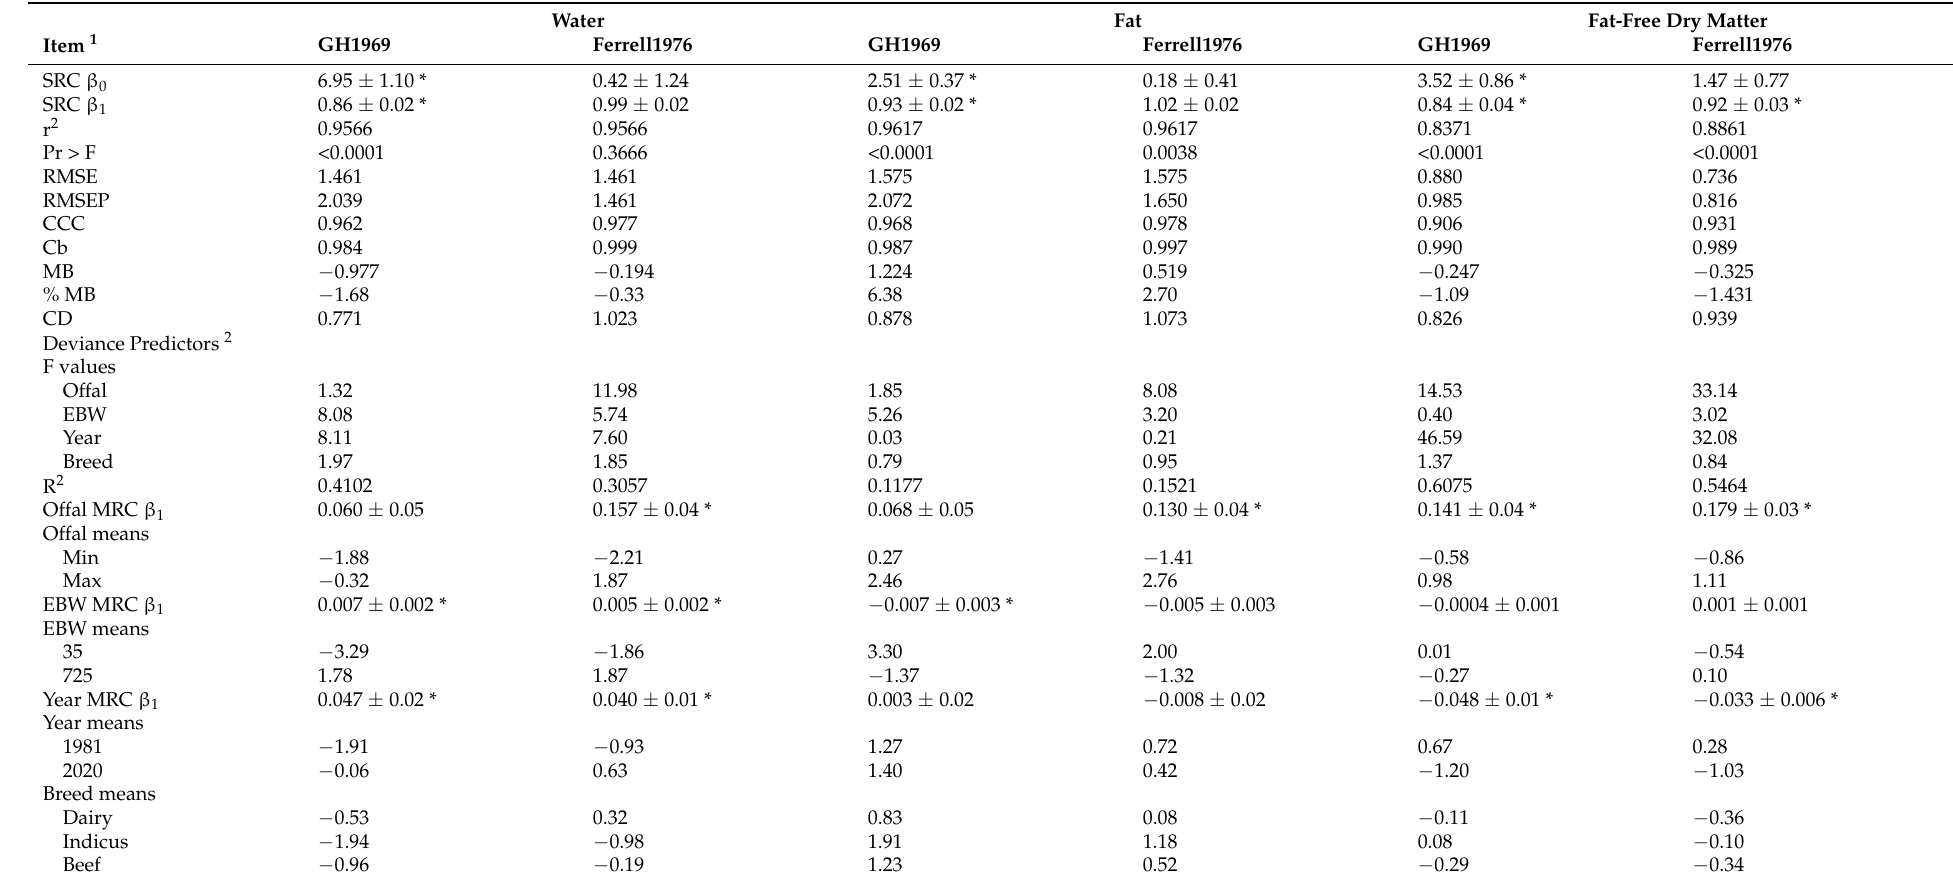
Table 13. Model evaluation of predicting empty body chemical water, fat, and fat-free dry matter assuming carcass chemical composition is known, and predictive variables of the deviance between observed and predicted empty body chemical components in the Empty Body-Carcass